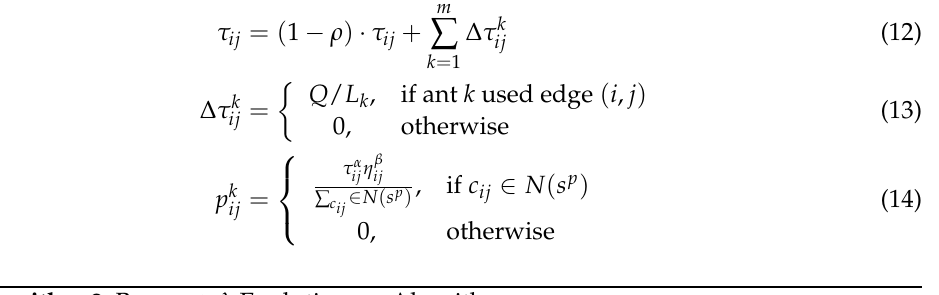
Algorithm 2: Base µ + λ Evolutionary